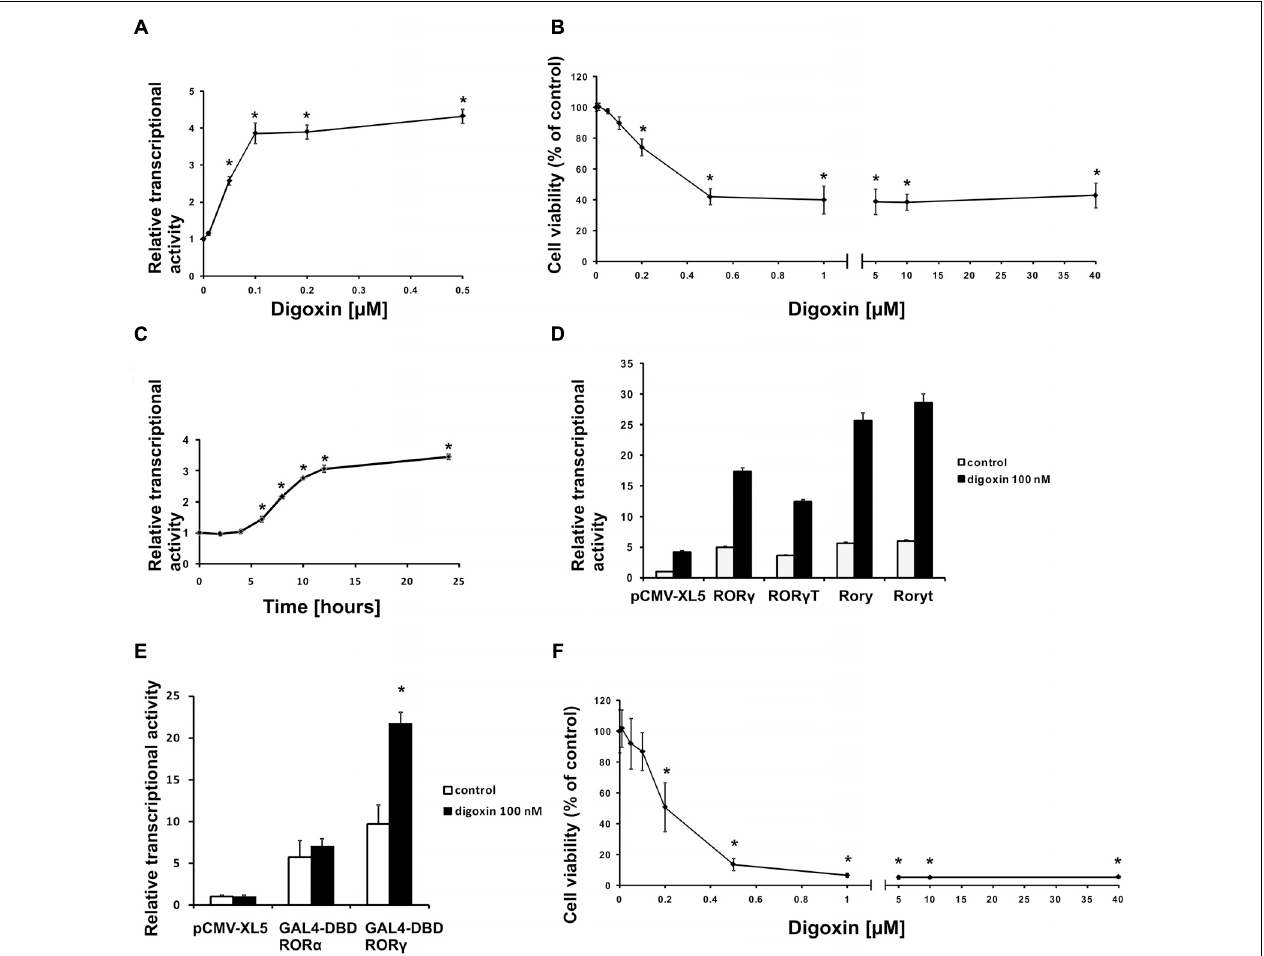
FIGURE 2 | Digoxin activates ROR γ -dependent transcription at subcytotoxic concentrations. (A) The effect of digoxin on ROR γ -HepG2. Mean ± SD, n = 6. (B) The effect of digoxin on HepG2 cell viability. Mean ± SD, n = 6. (C) A time course of digoxin (100 nM) in the ROR γ -HepG2 assay. Mean ± SD, n = 6. (D) Digoxin potentiates the effect of human ROR γ and ROR γ T and mouse Rory and Roryt overexpression in the ROR γ -HepG2 reporter cell line. Mean ± SD, n = 5. (E) Digoxin specifically activates the GAL4-DBD ROR γ fusion protein in the HepG2-pGL4.35 reporter cell line. Mean ± SD, n = 3. (F) The effect of digoxin on Th17 cell viability. Mean ± SD, n = 4 (four different donors); ∗ significantly different from control treatment at p <